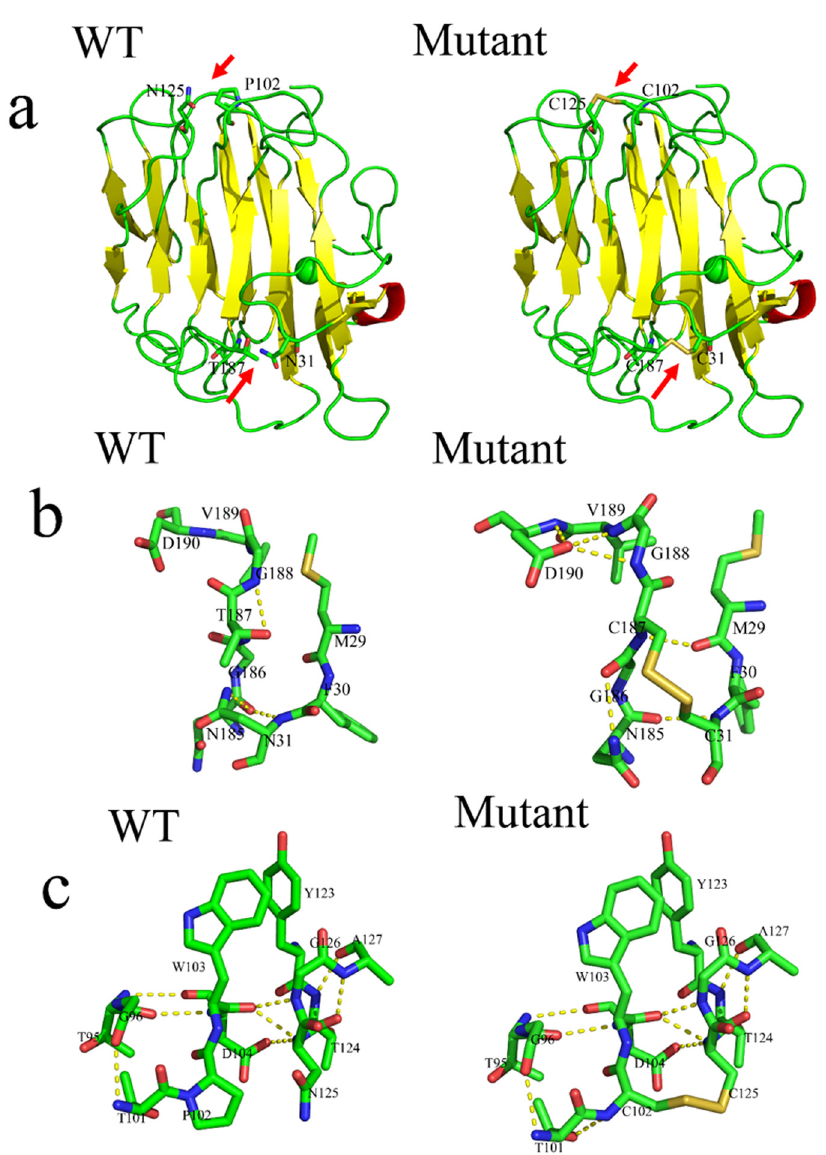
Fig 5. Comparison of the 3D structures of wild-type BglTM and N31C-T187C/P102C-N125C mutant (the mutant residues are shown in sticks). (a) Comparison of the overall 3D structures of wild-type BglTM and N31C-T187C/P102C-N125C mutant; (b) Comparison of the hydrogen bond network within the 5 Å region around the mutant site of N31C-T187C between wild-type BglTM and N31C-T187C/P102C-N125C mutant; (c) Comparison of the hydrogen bond network within the 5 Å region around the mutant site of P102C-N125C between wild-type BglTM and N31C-T187C/P102C-N125C